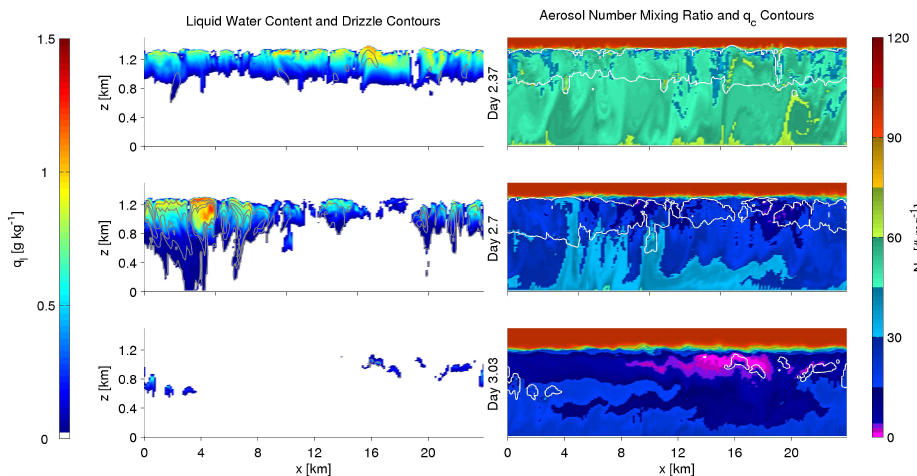
Fig. 5. Left column: x – z cross sections of liquid water content q l with grey contours [0.025 0.075 0.125gkg − 1 ] of drizzle water mixing ratio q r . Right column: x – z cross sections of total aerosol number concentration N a with the 0.01gkg − 1 of cloud water mixing ratio q c . Each row is separated by approximately 8h. Note thin region of extremely depleted aerosol in upper MBL in the bottom right